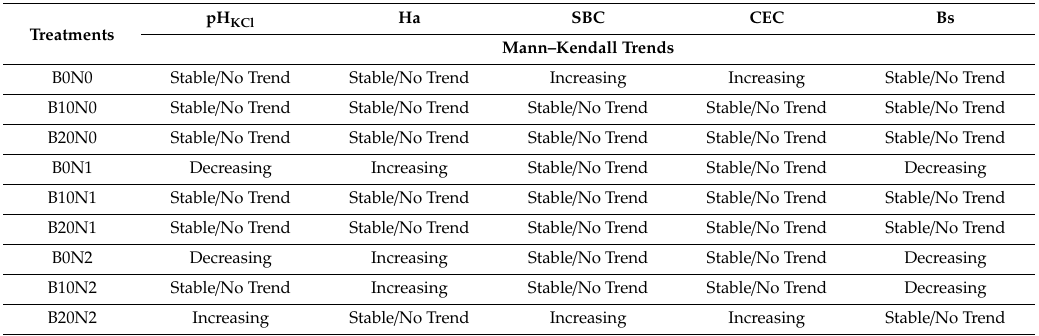
Table 3. Dynamics of soil pH and sorptive parameters according to the results of the Mann–Kendall test. pH KCl Ha SBC CEC Bs Treatments B0N0 Stable / No Trend Stable / No Trend Increasing Increasing Stable / No Trend B10N0 Stable / No Trend Stable / No Trend Stable / No Trend Stable / No Trend Stable / No Trend B20N0 Stable / No Trend Stable / No Trend Stable / No Trend Stable / No Trend B0N1 Decreasing Increasing Stable / No Trend Stable / No Trend B10N1 Stable / No Trend Stable / No Trend Stable / No Trend Stable / No Trend Stable / No Trend B20N1 Stable / No Trend Stable / No Trend Stable / No Trend Stable / No Trend Stable / No Trend B0N2 Decreasing Increasing Stable / No Trend Stable / No Trend